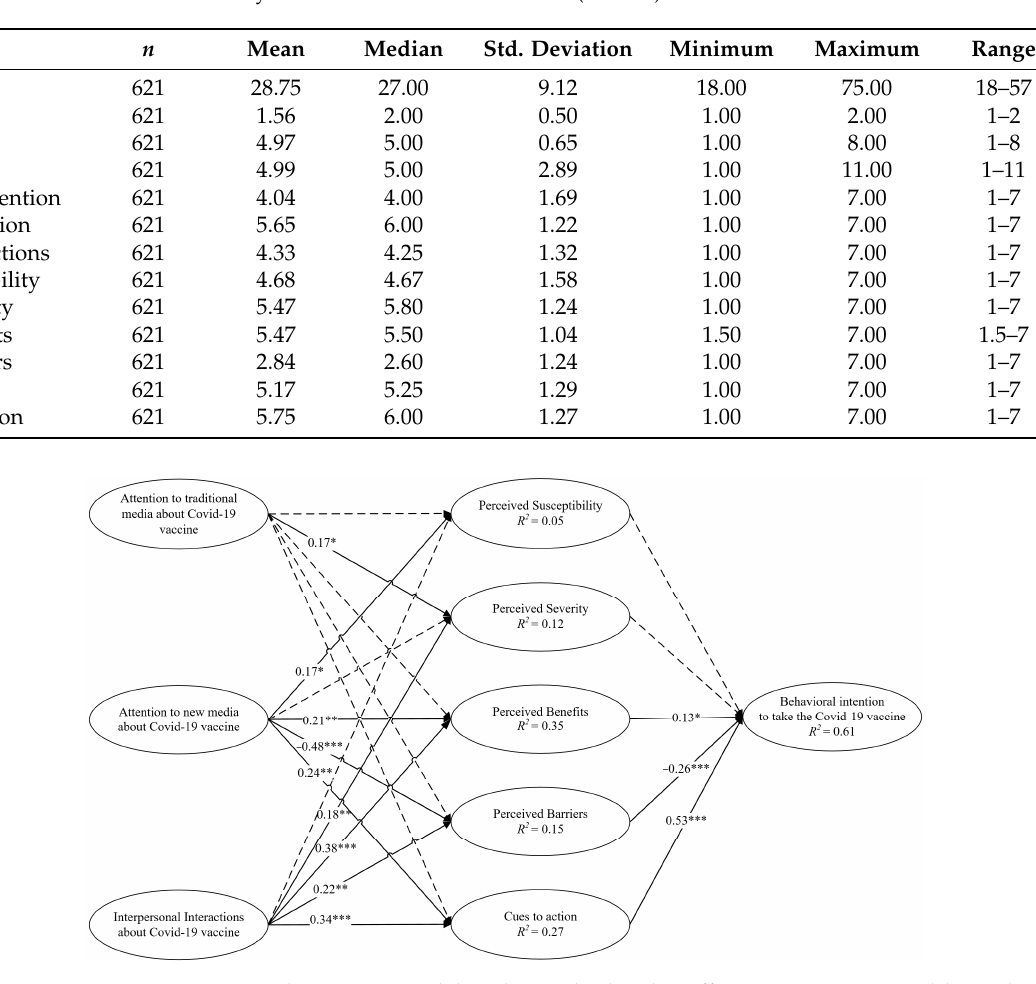
Figure 2. Structural equation model with standardized coefficients. Note: Dotted lines denote hypothesized nonsignificant paths. * p < 0.05, ** p < 0.01, *** p < 0.001.